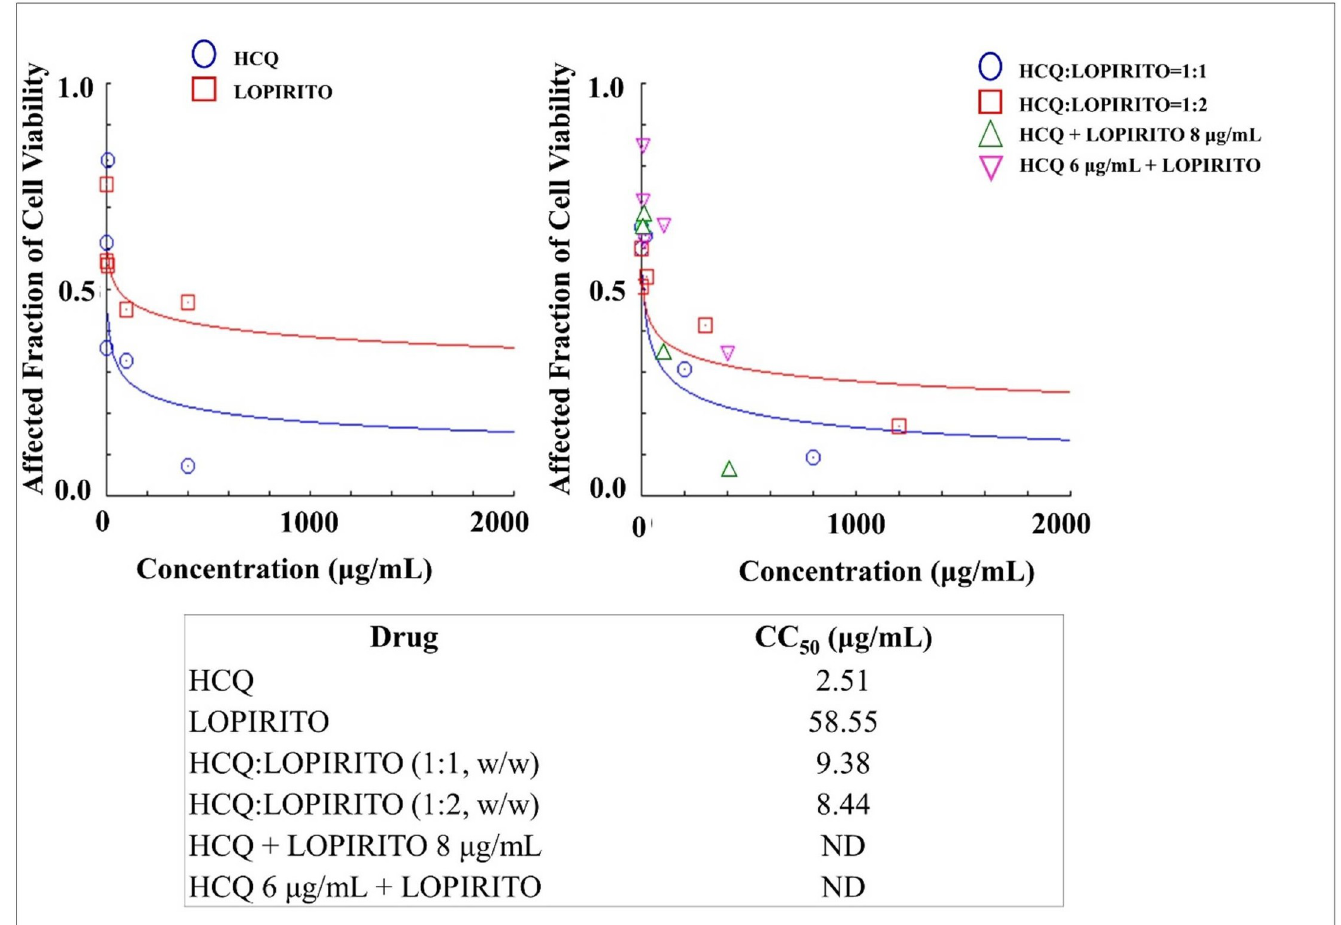
Fig 11. The cytotoxicities of Hydroxychloroquine (HCQ) and Lopinavir-Ritonavir (LOPIRITO) as a single drug (left) and dual drug combination in constant and non-constant ratios (right) analysed by using CompuSyn Software (n = 3). At non-constant ratios of HCQ + LOPIRITO 8 μ g/mL, LOPIRITO was added at a concentration of 8 μ g/mL to each increased levels of HCQ i.e. 0.2, 2, 10, 100, and 400 μ g/mL. On the other hand, HCQ was then added at a concentration of 6 μ g/mL to each increased levels of LOPIRITO i.e. 0.2, 2, 10, 100, and 400 μ g/mL to produce HCQ 6 μ g/mL + LOPIRITO.